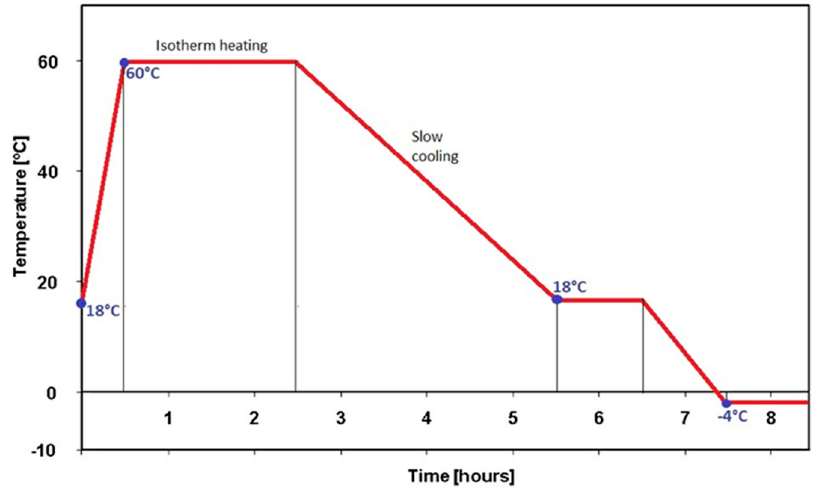
Figure 2. Heat treatment procedure of the multi-layered plasticine slabs.